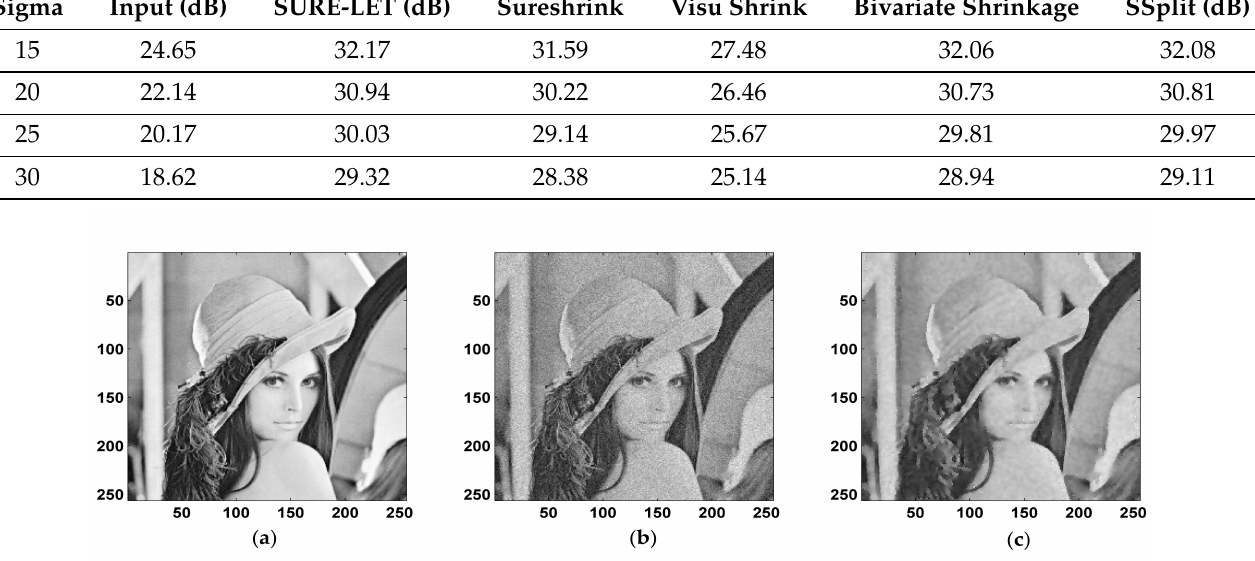
Figure 16. ( a ) Original image, ( b ) Image with the addition of Gaussian white noise (Input PSNR = 22.11 dB), ( c ) Denoising with proposed method (Output PSNR = 29.82 dB).